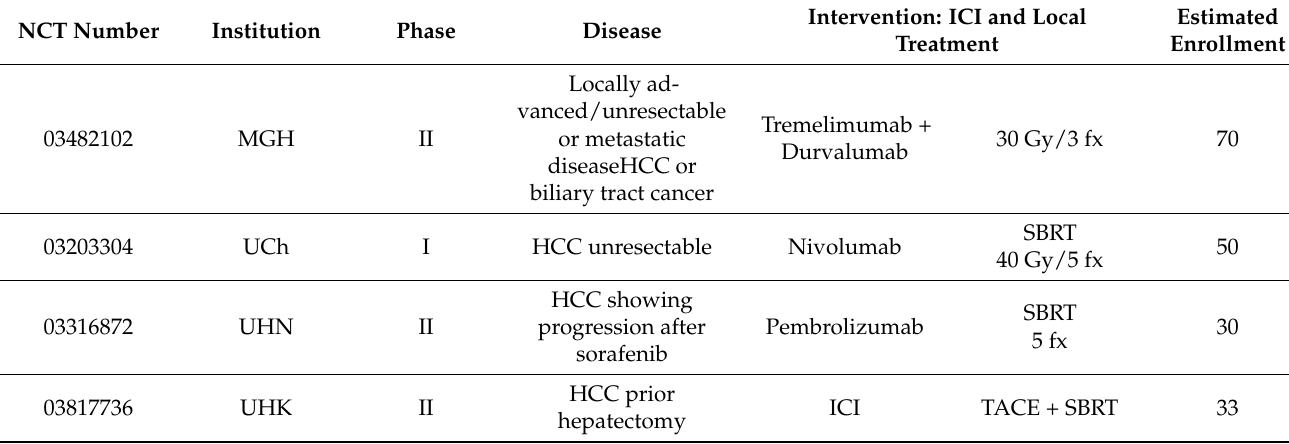
Table 7. Ongoing clinical trials on external-beam RT and Immune Checkpoint Inhibitors for patients with HCC. NCT